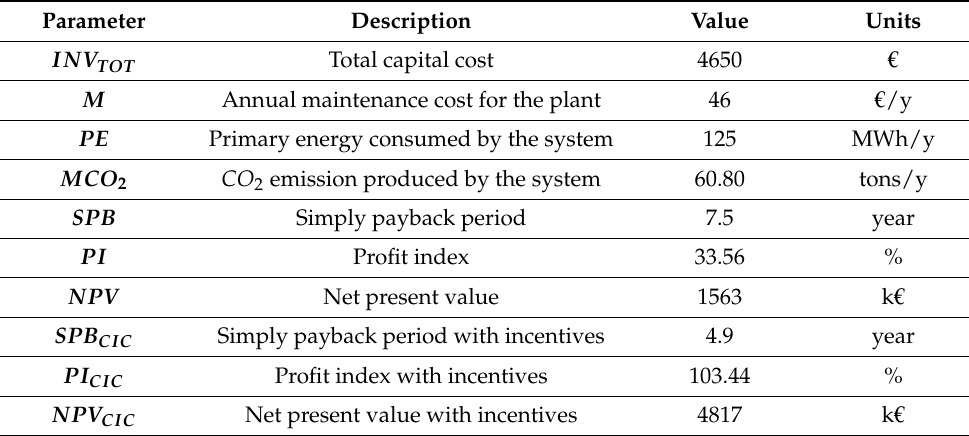
Table 6. Results from thermoeconomic and environmental